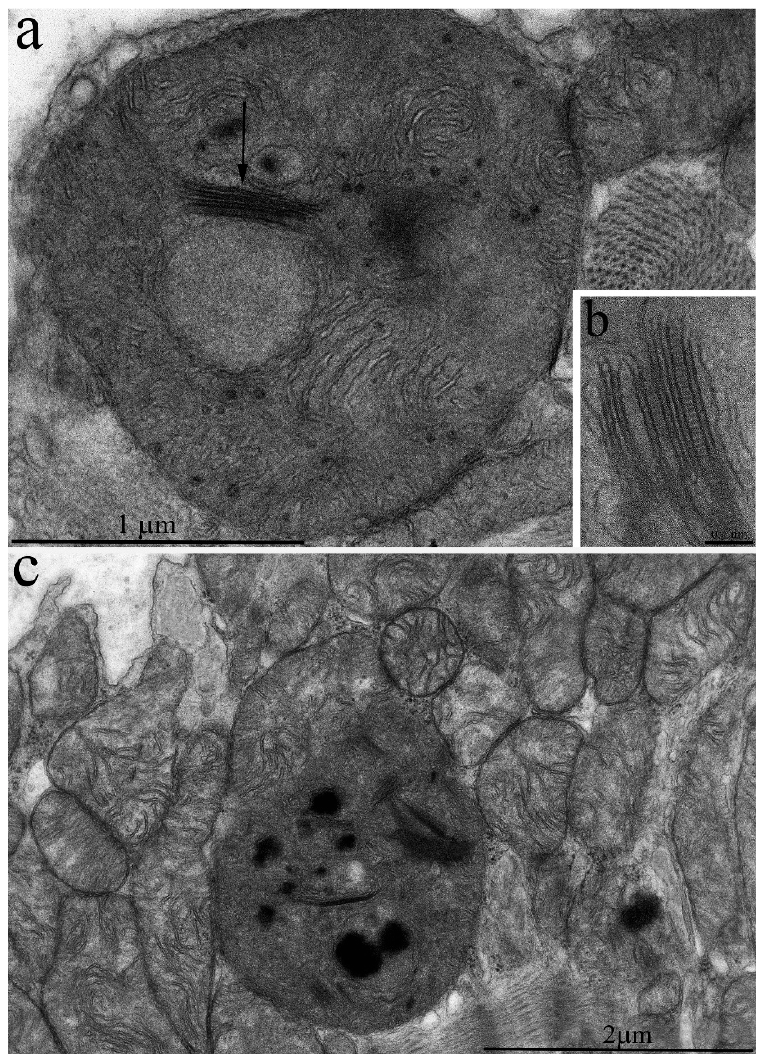
Figure 8. Ultrastructure of individual cardiomyocyte mitochondria in a 11-year-old naked mole rat: ( a) Mitochondria with disrupted crista ultrastructure. The arrow shows the appearance of a bundle of cristae. ( b ) The bundle at higher magnification. ( c ) Mitochondrial population of a left ventricular cardiomyocyte. Mitochondria with bundles are very rare.